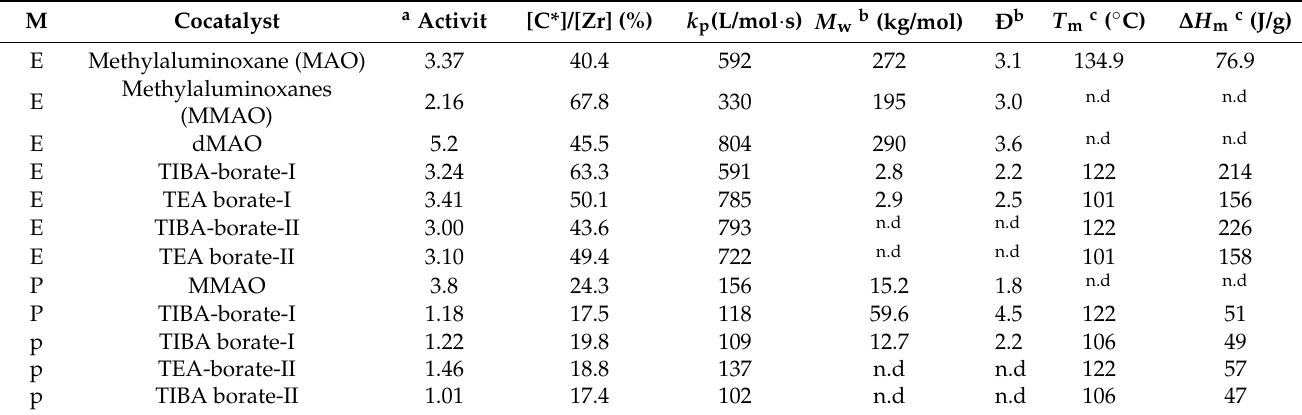
Table 5. Comparisons between reported and recent experimental results under the same experimental conditions for Mt-II catalyzed polyethylene and polypropylene [26,30,39,59]. M